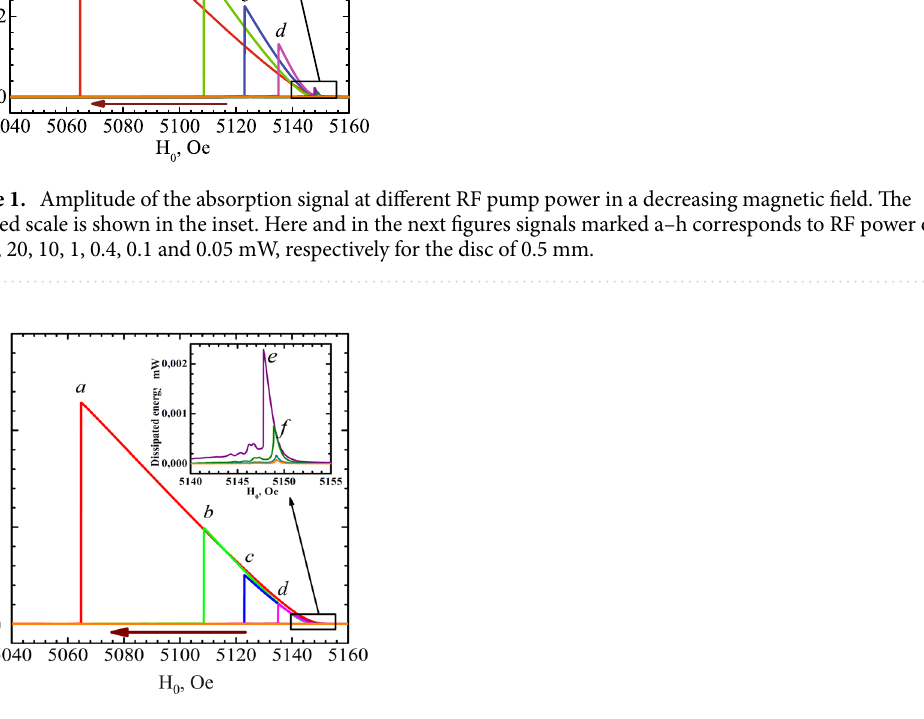
Figure 2. The energy dissipated by a magnon spin system at different level of exciting power. The energy was calculated as a product of absorption signal (Fig. 1) on the amplitude of RF field. The enlarged scale is shown in the